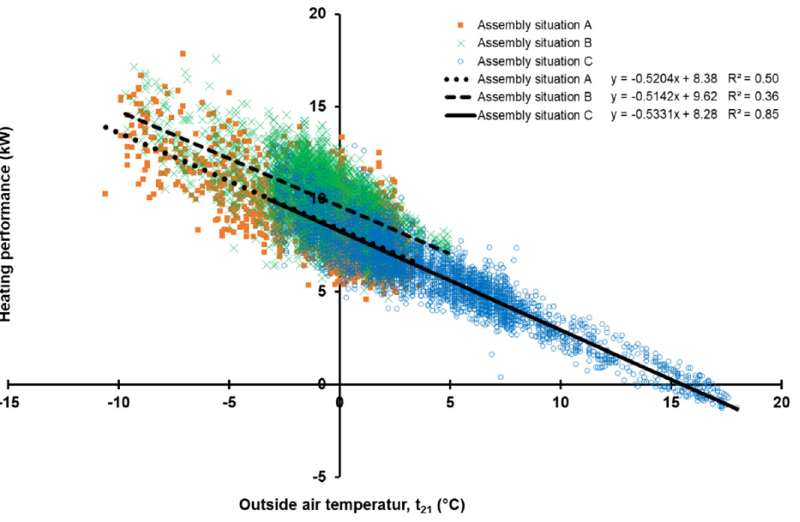
Figure 5. Data and relationship between heating performance of the exchange scrubber pilot plant (at the three different assembly situations of the heat exchanger) and outside air temperature (t 21 ).